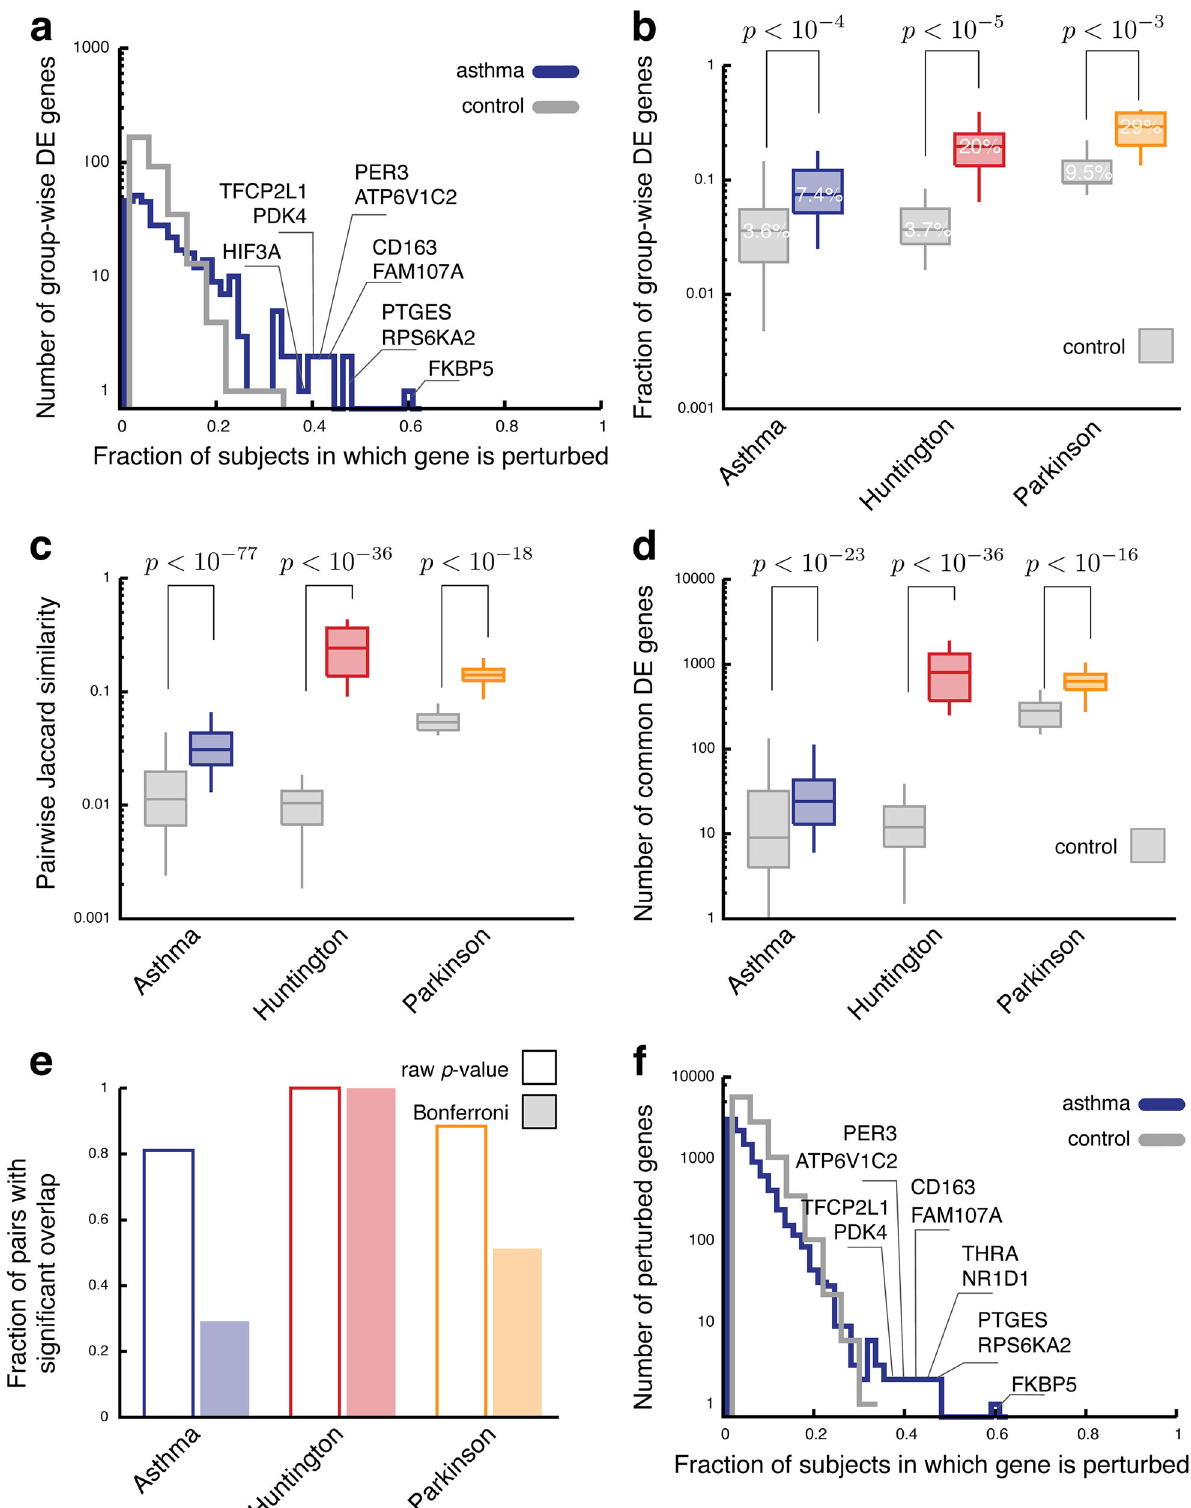
Fig. 2 Heterogeneity among the PEEPs. a Distribution of the fraction of all PEEPs in which a gene appears that has been identi fi ed in a standard group-wise analysis (for asthma). b Fraction all group-wise DE genes found in the PEEPs for asthma patients. c , d Pairwise overlap of the genes in the PEEPs as measured by the Jaccard index ( c ) and the number of common genes ( d ). e Fraction of all case subject pairs whose gene overlap is statistically signi fi cant (Fishers ’ s exact test, p -value < 0.05). f Distribution of the fraction of asthma patient PEEPs in which a gene appears